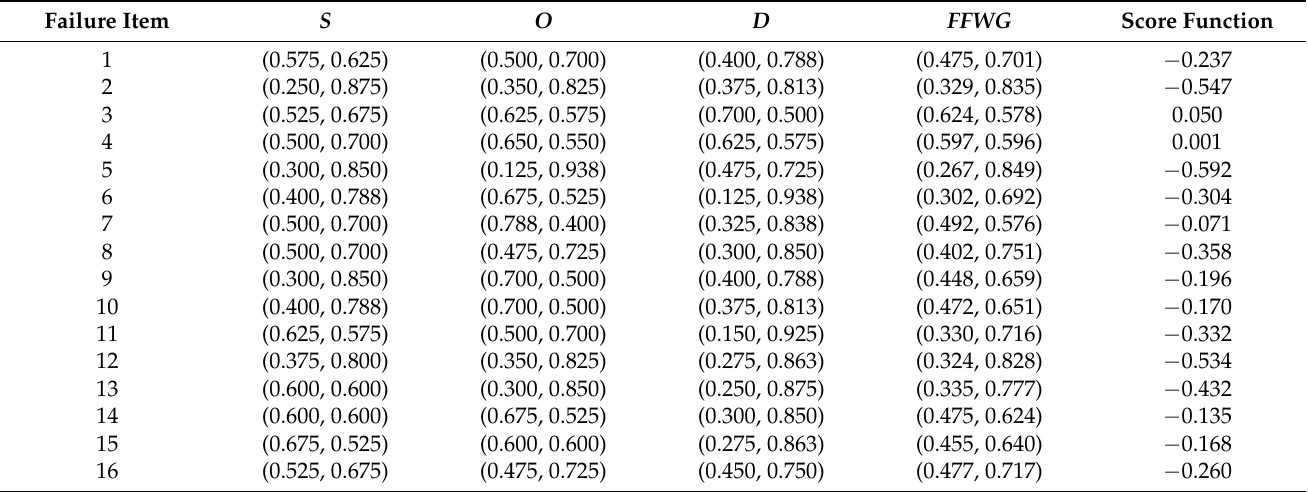
Table 10. The results of the Fermatean fuzzy weighted geometric ( FFWG ) values by the proposed